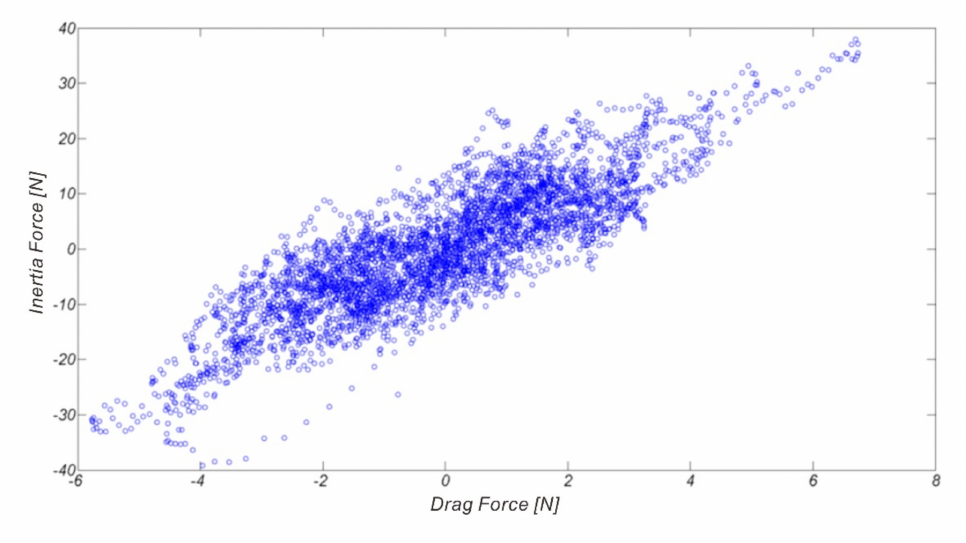
Figure 20. Trajectories of the drag force and inertia force that comprise the wave